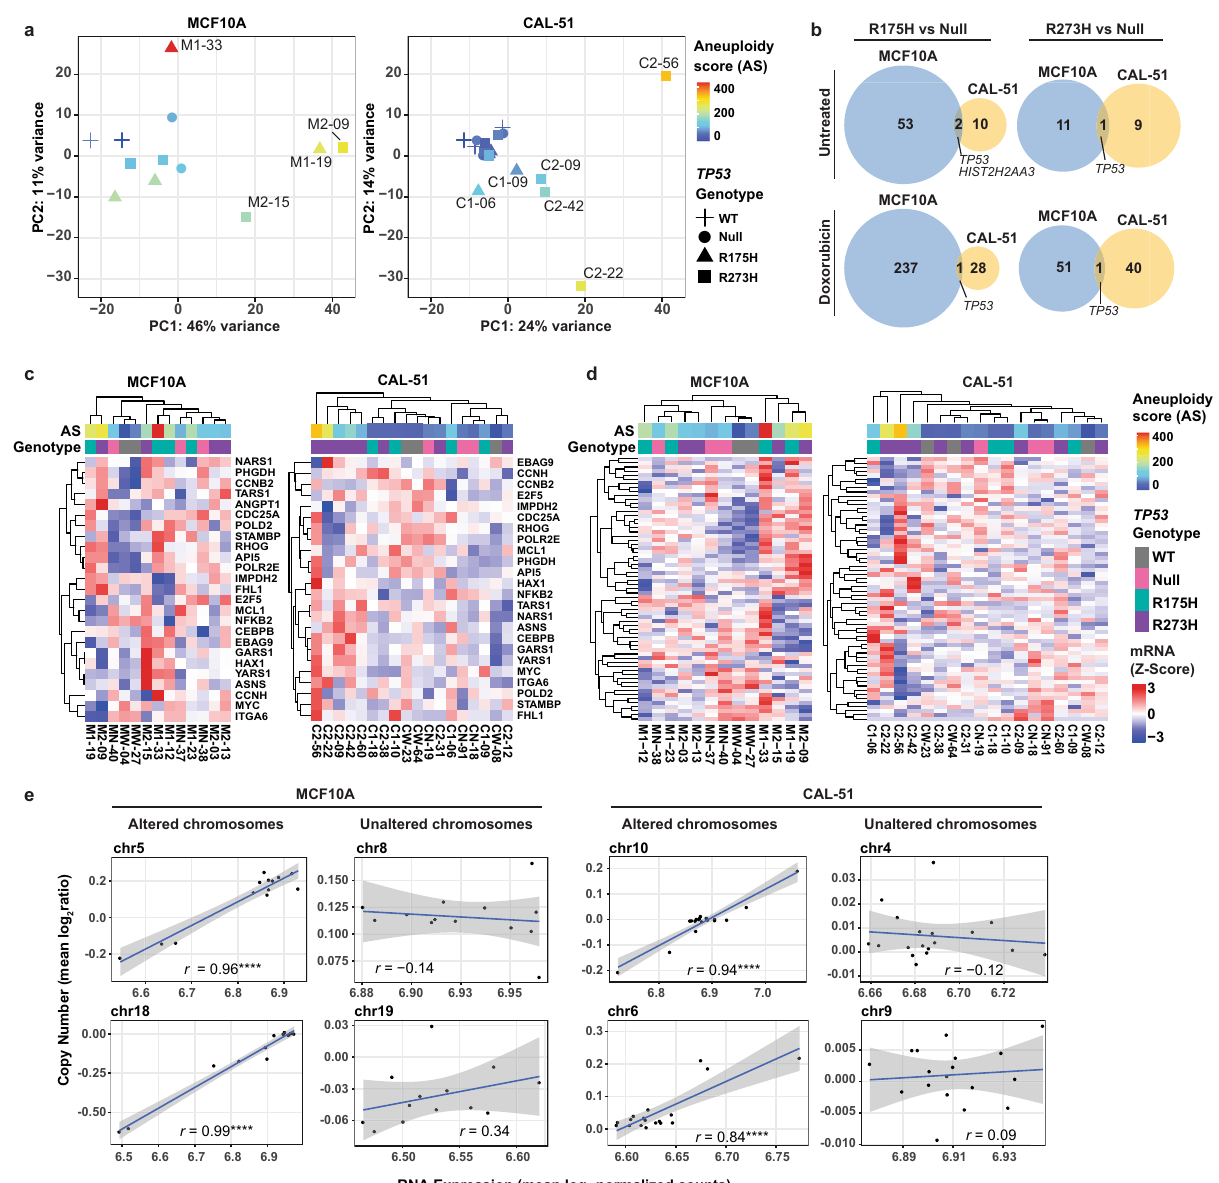
Fig. 3 Gene expression changes are associated with aneuploidy and not mutant p53 expression. a Principal component (PC) analysis of gene expression values for untreated MCF10A (left panel) and CAL-51 (right panel) isogenic cell lines. b Venn diagrams showing the overlap between differentially expressed genes in R175H (left) and R273H (right) cell lines compared to null cells in MCF10A (blue) and CAL-51 (yellow) models. Cells were either untreated (top) or treated with doxorubicin (0.2 µ M, 6 h) (bottom). Cell lines used in RNA-seq analyses are shown in Supplementary Fig. 5a. c Hierarchical clustering and comparison of gene expression for previously reported mutant p53-associated upregulated genes 41 from the indicated MCF10A (left panel) and CAL-51 (right panel) cell lines. d Hierarchical clustering and comparison of gene expression for the karyotype heterogeneity associated HET70 gene signature 43 from the indicated MCF10A (left panel) and CAL-51 (right panel) cell lines. e Scatter plots comparing average chromosomal copy number with chromosomal RNA expression for MCF10A (left panel, n = 13) and CAL-51 (right panel, n = 18) cell lines across frequently altered or unaltered chromosomes. Each point represents the mean per cell line. The blue line represents a linear model of the best fi t, with the gray area representing the 95% con fi dence intervals. r = Pearson correlation coef fi cient, **** P < 0.0001, Pearson correlation. Source data are provided in the Source Data